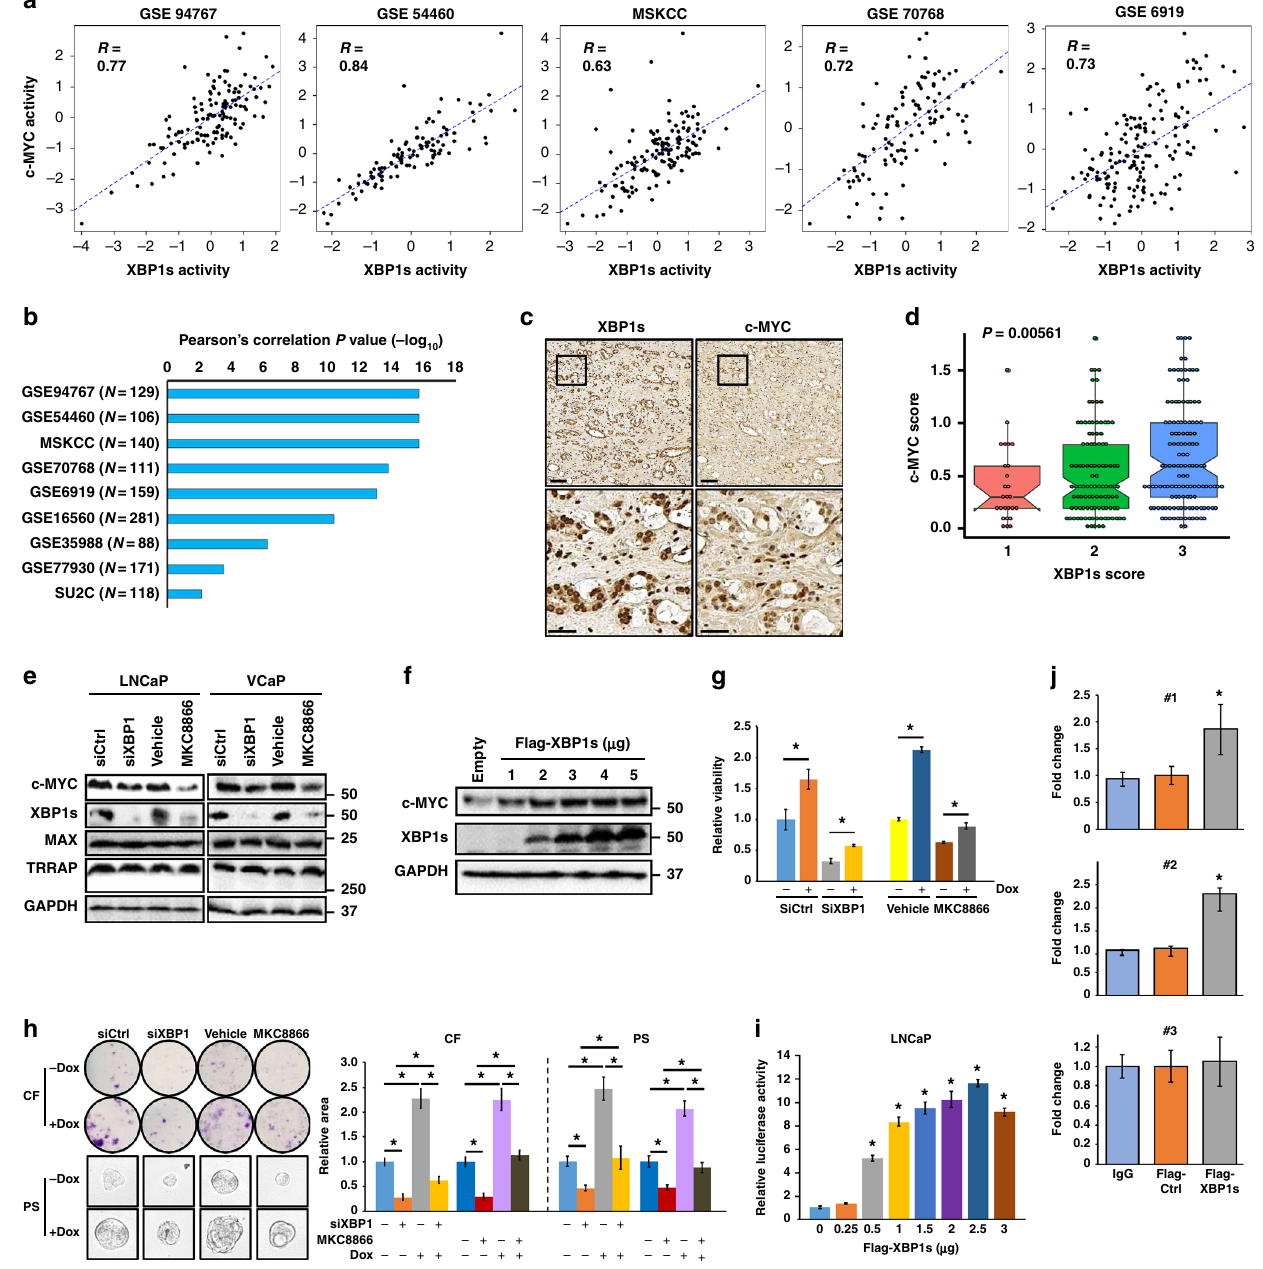
Fig. 4 XBP1s activates c-MYC expression and activity in human PCa. a The plots show signi fi cant positive correlation between XBP1s and c-MYC target gene expression in fi ve independent PCa datasets. b The bar graph shows the P values of the correlation between XBP1s and c-MYC target gene expression in nine different human PCa cohorts, using the Pearson correlation test. c Consecutive sections of human PCa prostatectomy samples were immunostained for XBP1s and c-MYC. Representative images from one patient at two different magni fi cations are shown. Scale bars, 100 μΜ (upper panel) and 30 μΜ (lower panel). d Tissue microarrays containing 260 tumor samples stained with either a XBP1s or c-MYC-speci fi c antiserum were scored. Dots represent values of individual samples; thick horizontal lines represent the median; box represents the upper and lower quartile; whiskers represent 1.5 times interquartile range. The P value indicates the signi fi cance of correlation between XBP1s and c-MYC scores by ANOVA. e LNCaP or VCaP cells were treated with either siXBP1 or MKC8866, and c-MYC levels were determined. f LNCaP cells were transfected with either empty vector or fl ag-XBP1s expression vector. XBP1s and c-MYC levels were then determined after 2 days. g LNCaP c-MYC inducible cells were treated with either siXBP1 or MKC8866 and then grown with or without doxycycline (Dox). Cell viability was measured after 3 days. h Same procedure was performed as in g , colony formation (CF) was measured after 2 weeks while prostatospheres (PS) after 1 week. i LNCaP cells were transfected with 1 μ g of pGL3-MYC luciferase reporter plasmid plus either empty vector (pCDNA3) or the pCDNA3-Flag-XBP1s plasmid. Luciferase activity was determined after 48 h. Results are from a representative experiment in triplicate. * Indicates statistical differences in LUC values compared to vector-transfected cells ( P < 0.05) by Student's t -test. j LNCaP cells were transfected with either empty pCDNA3 vector (Ctrl) or the pCDNA3-Flag-XBP1s plasmid. After 48 h, ChIP assay was performed using Flag antibody. The data are representative of two experiments in duplicate. Two responsive sites (#1 and #2) as well as one non-responsive site (#3) are presented. * P < 0.05, Student's t -test, error bars denote the